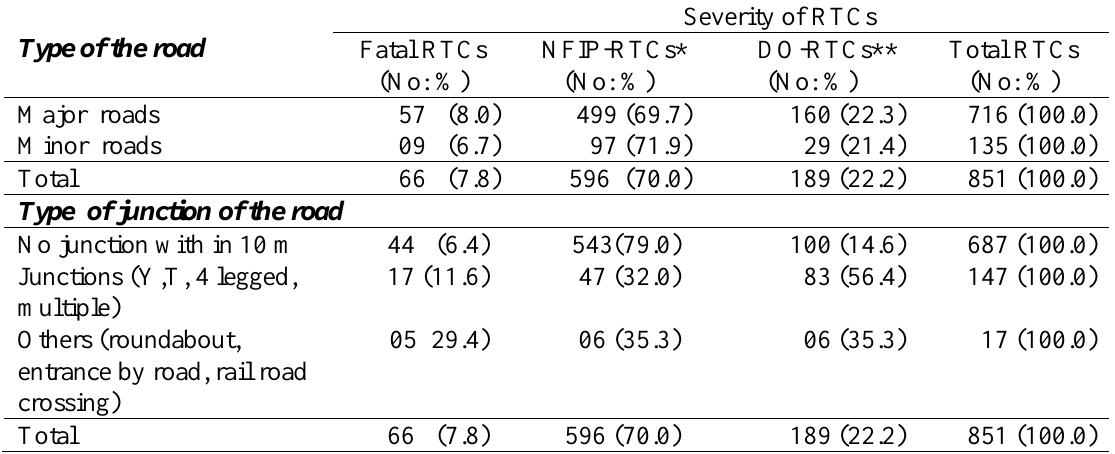
Table 2: Distribution of the severity of RTCs by the road characteristics in KPD Type of the road